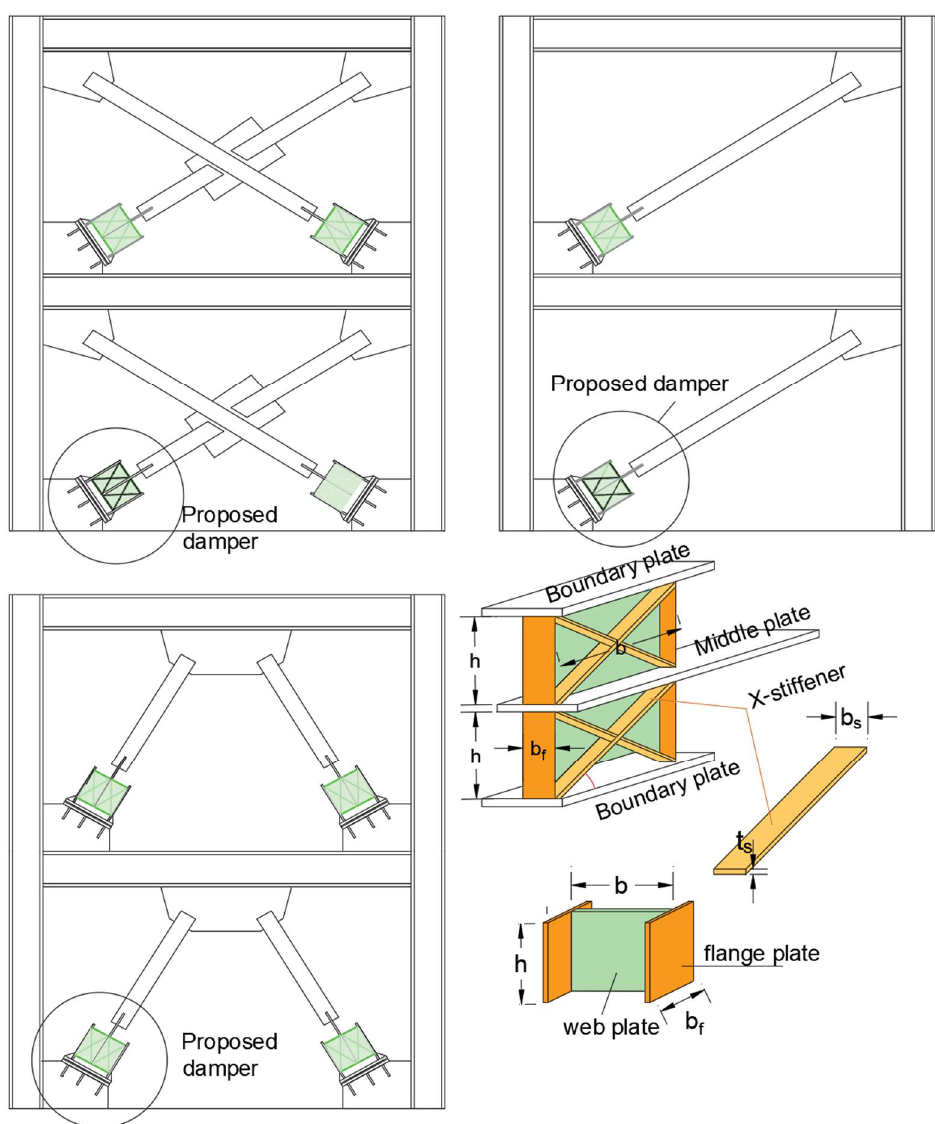
Figure 1. Schematic view and details of proposed damper.